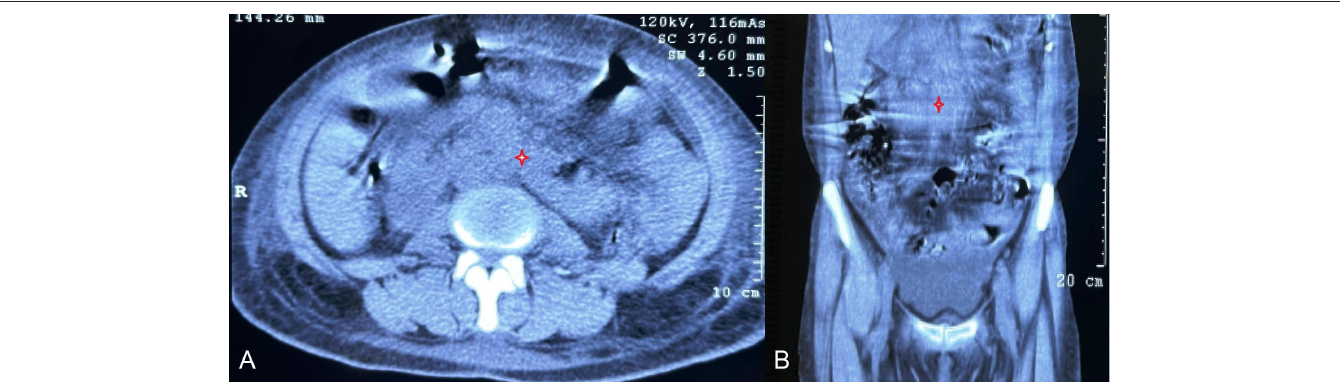
Figure 1. (A) Non-enhanced axial CT scan of the abdomen of the patient showing an HSK with isthmus (highlighted) lying anterior to the aorta and (B) depicting